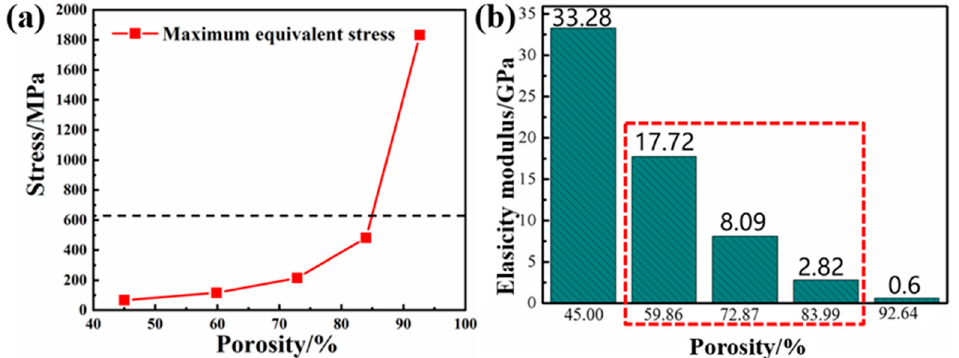
Figure 3. ( a ) Line diagram of the maximum equivalent stress experienced by a gradient porous structure column with different porosity. ( b ) Elastic modulus of gradient structure column with different porosity.